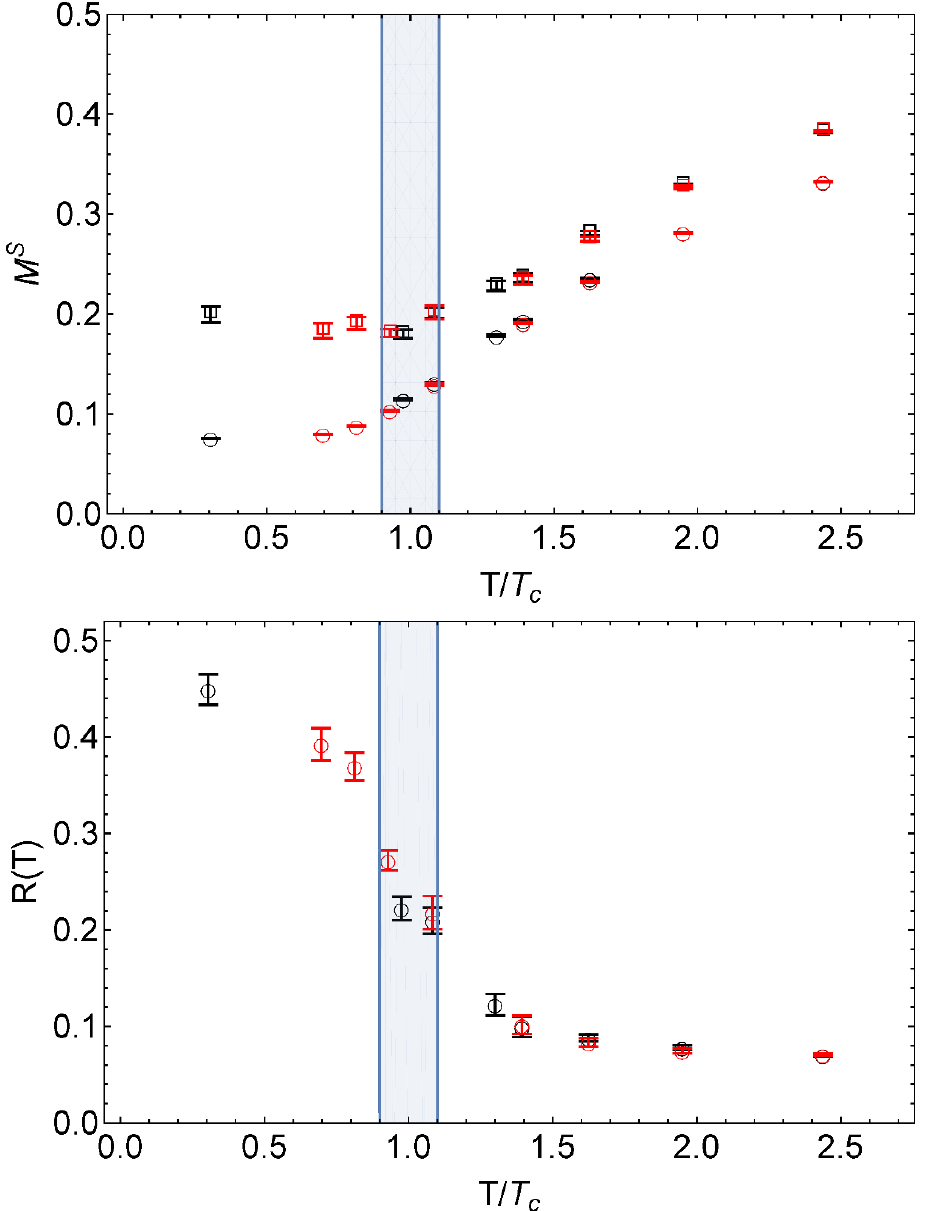
Figure 9 . Screening masses of pseudoscalar (circles) and scalar (squares) mesons (top panel) and the corresponding mass ratio de(cid:12)ned in eq. (4.5) (bottom panel). Black and red points are extracted from ensembles with N t (cid:2) 16 3 and N t (cid:2) 16 2 (cid:2) 24 lattice points, respectively. The temperature is expressed in units of T c . The blue vertical band denotes the uncertainty of T c itself.